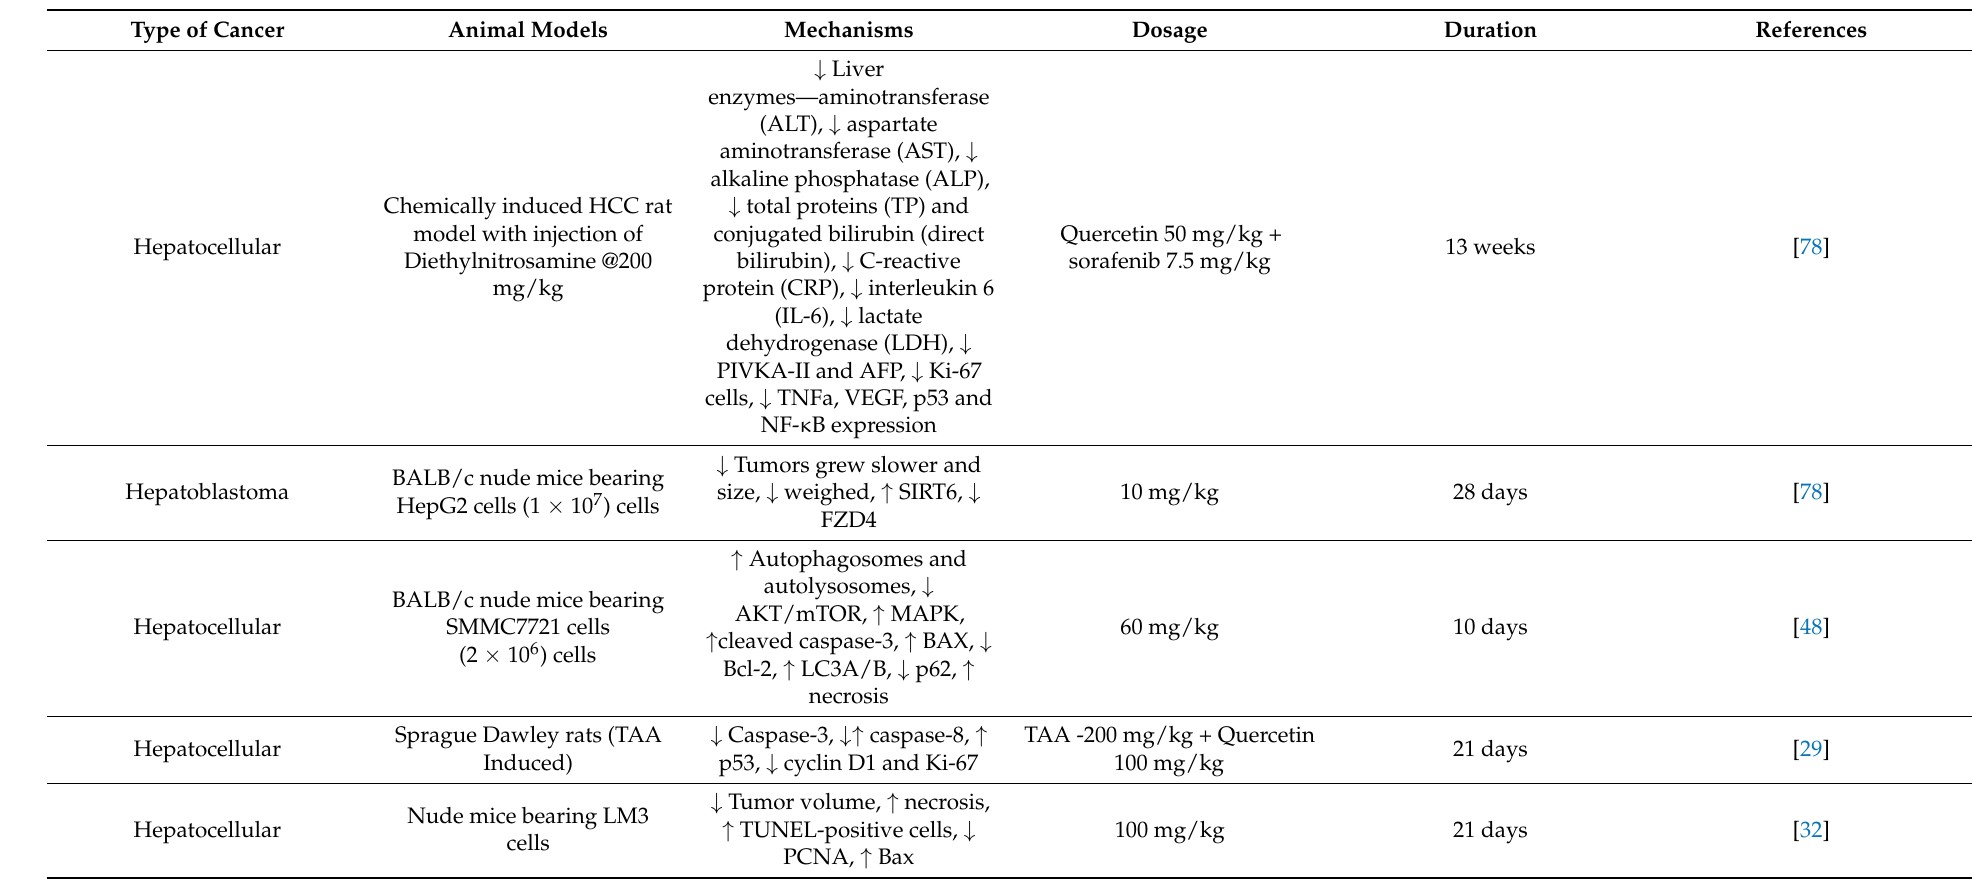
Table 3. Apoptotic effects of quercetin on liver cancer based on in vivo